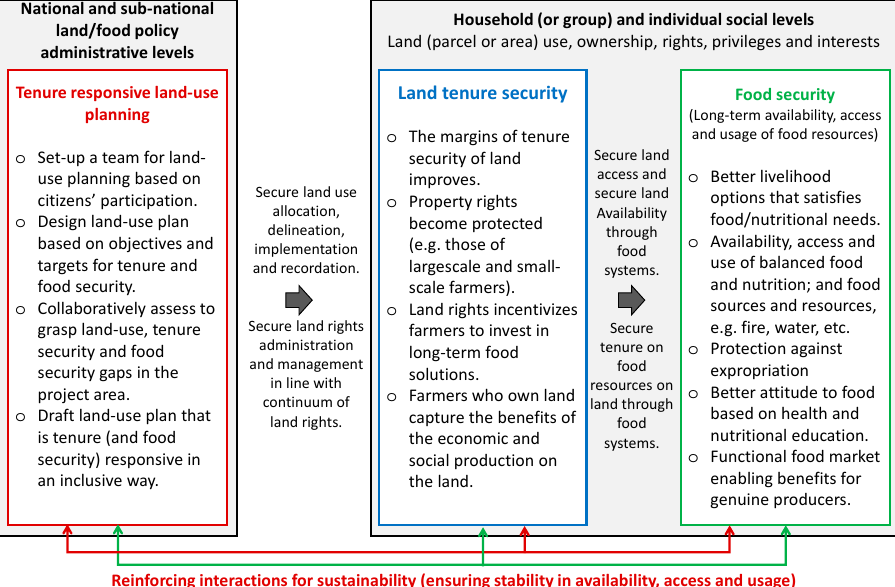
Figure 2. Framework for food security through tenure responsive land-use planning.